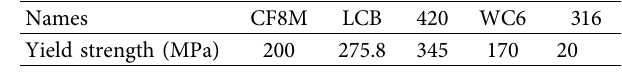
Table 5: Yield strength of each